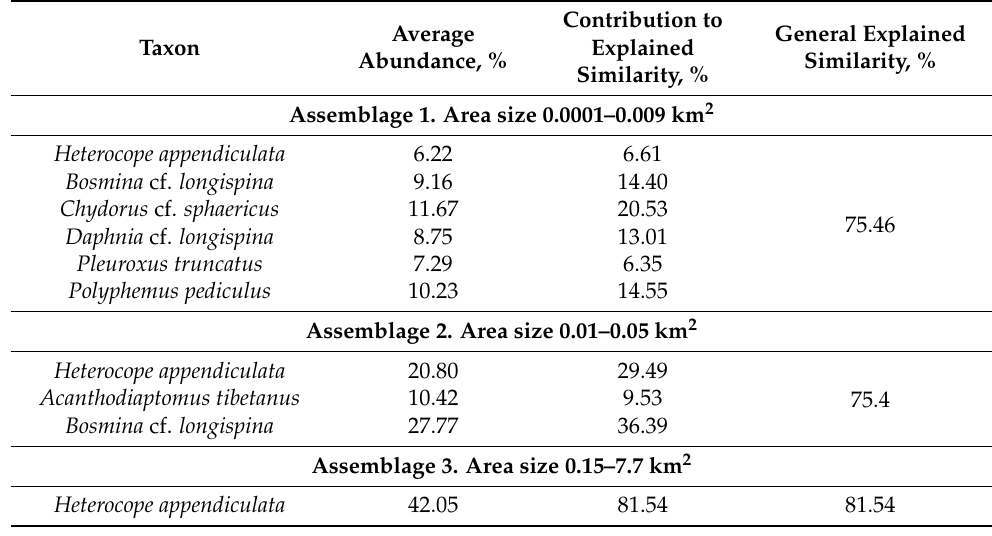
Table 3. Characteristic species of planktonic crustacean assemblages from waterbodies with different area size.